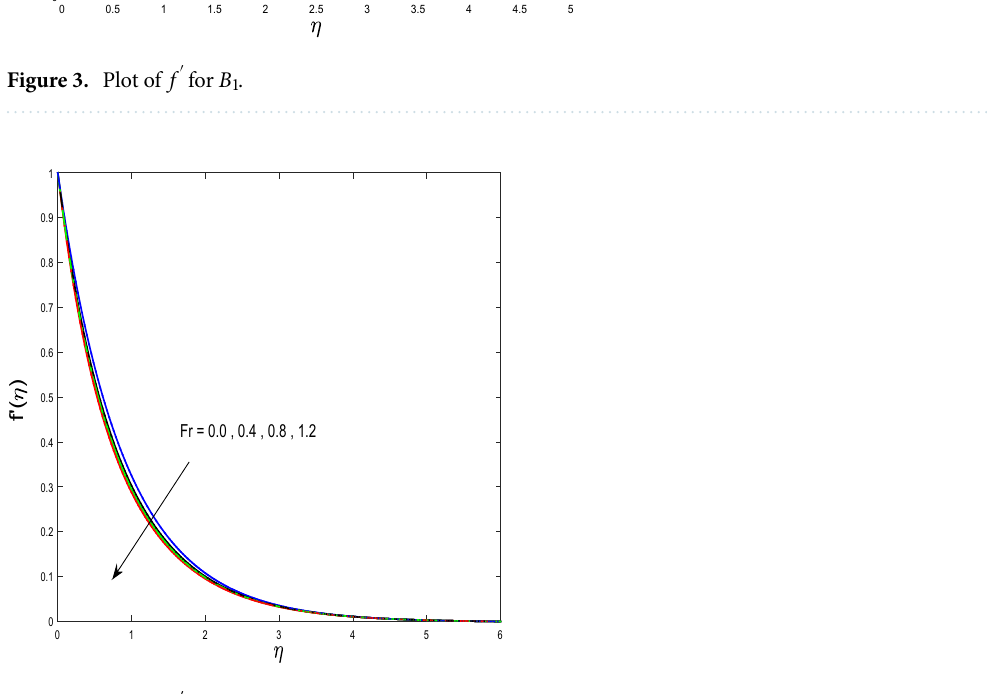
Figure 4. Plot of f ′ for Fr